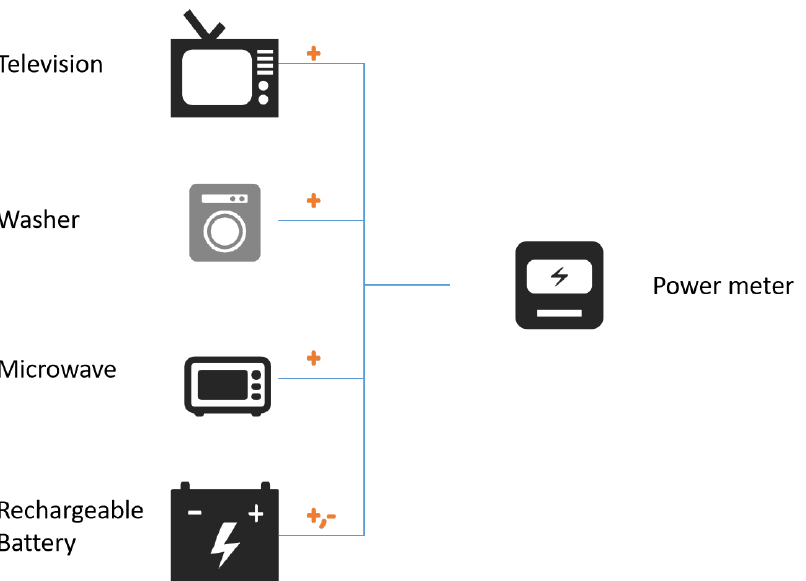
Figure 1. New topological logic diagram of electrical microenvironment with potential safety